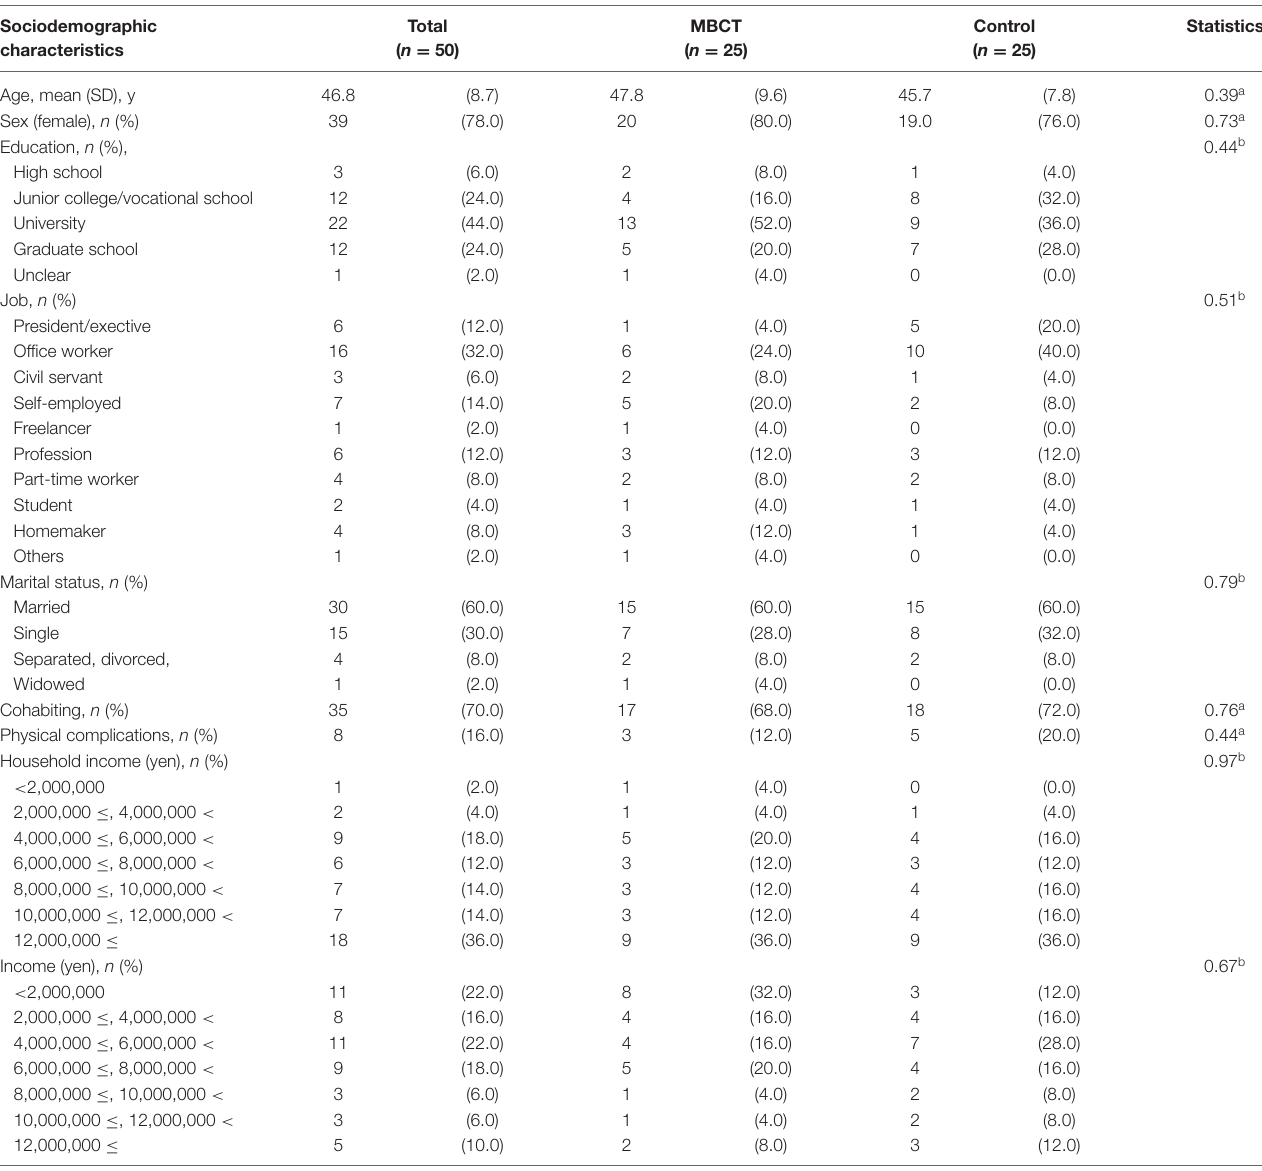
TABLE 3 | Baseline sociodemographic